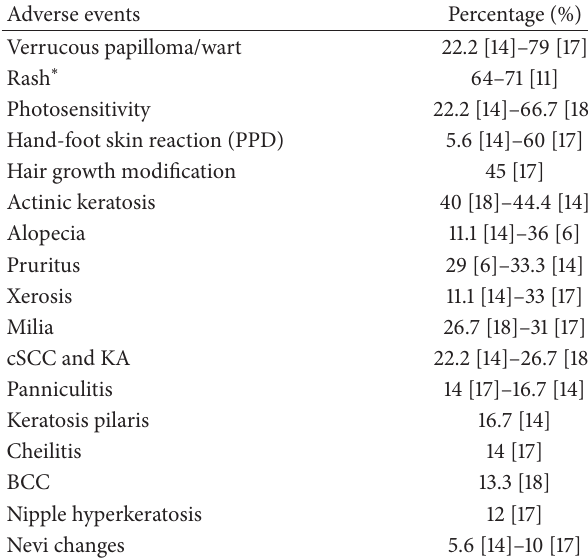
Table 1: Percentage of common ( > 5%) cutaneous adverse events with vemurafenib